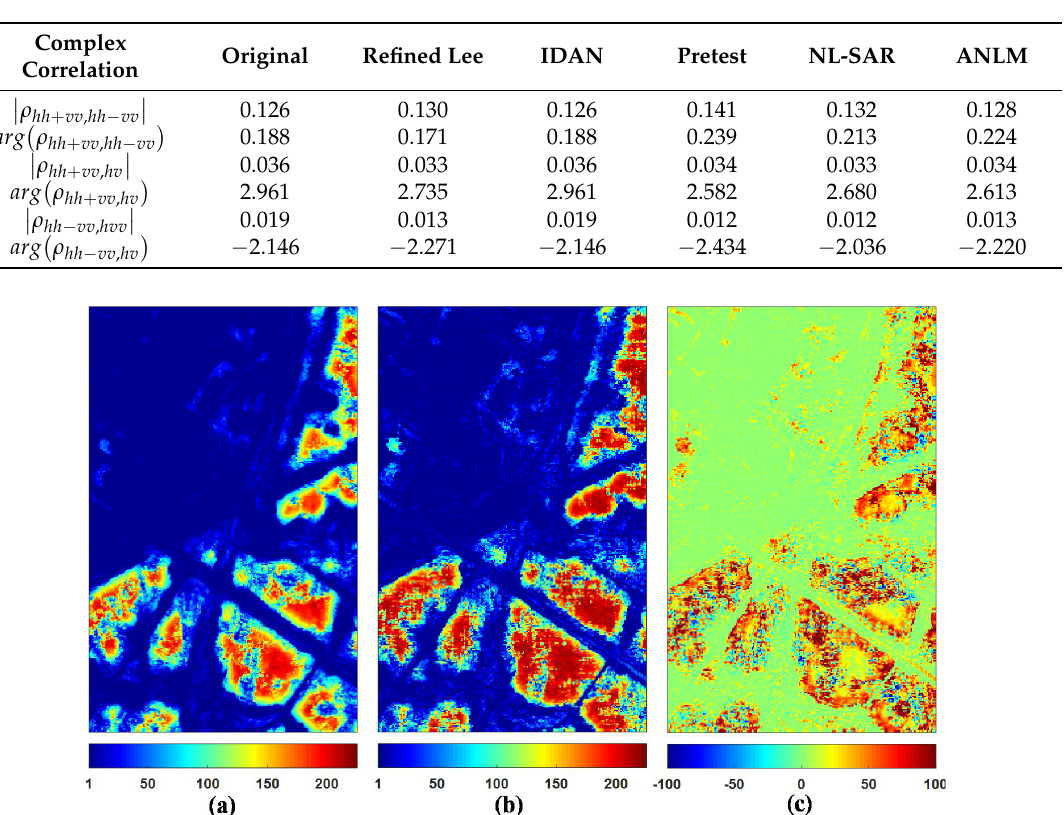
Table 2. Quantitative comparison of different filters by all possible complex correlations on the marked region 4 in Figure 7a.